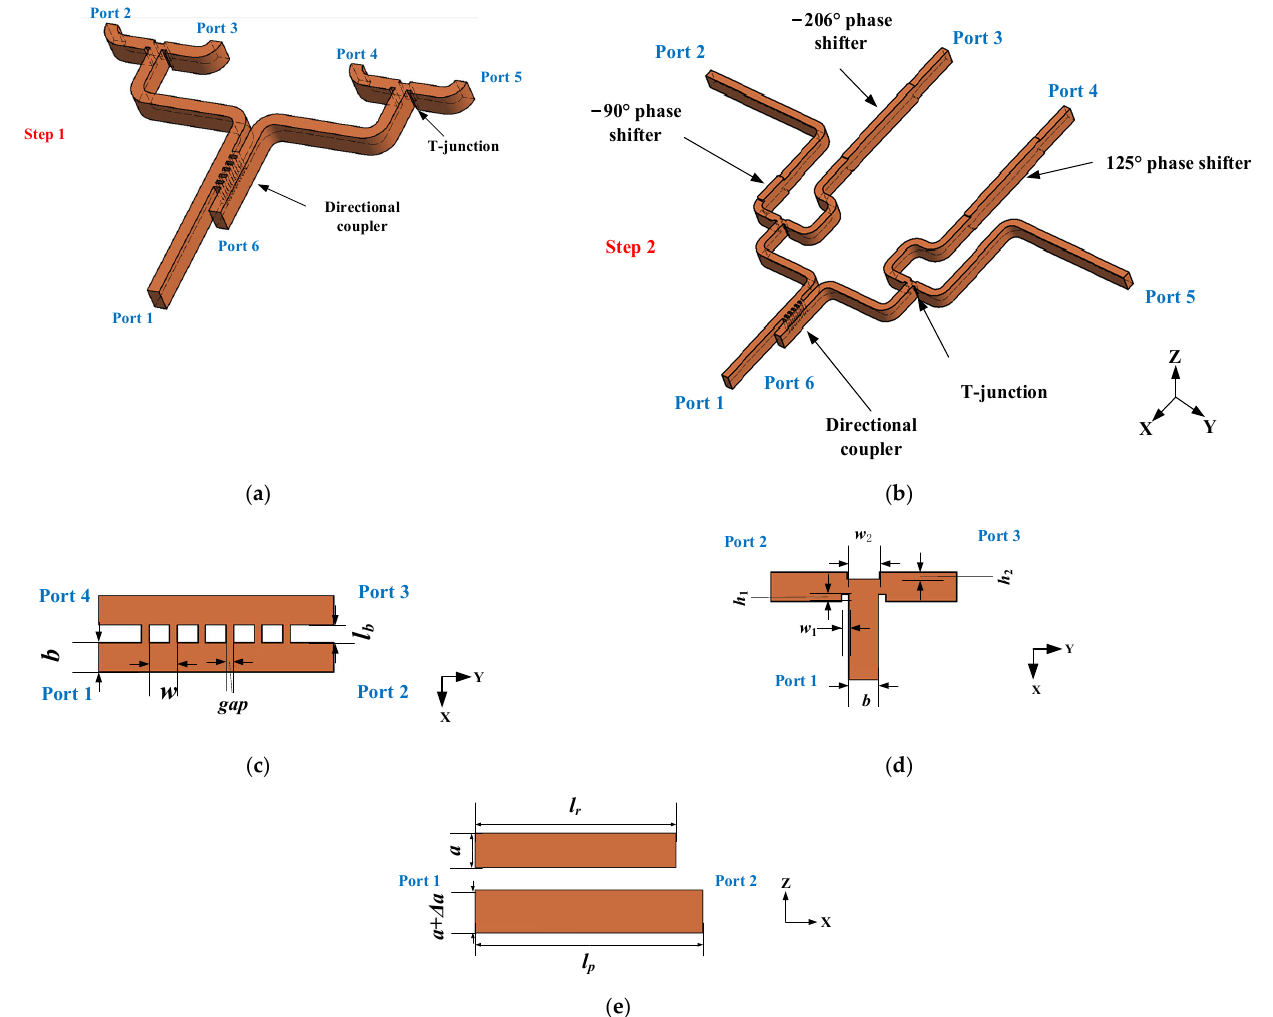
Figure 5. The structure of the proposed feed network, ( a ) the first step of feed network; ( b ) the sec ‐ ond step of feed network; ( c ) the diagram and relevant dimensions of multiple directional coupler; ( d ) the diagram and relevant dimensions of T ‐ junction; ( e ) the diagram and relevant dimensions of phase shifter, ( a = 2.54 mm, b = 1.27 mm, l b = 0.77 mm, w = 0.78 mm, gap = 0.43 mm, w 1 = 0.47 mm, w 2 = 1.1 mm, h 1 = 0.3 mm, h 2 = 0.3 mm).